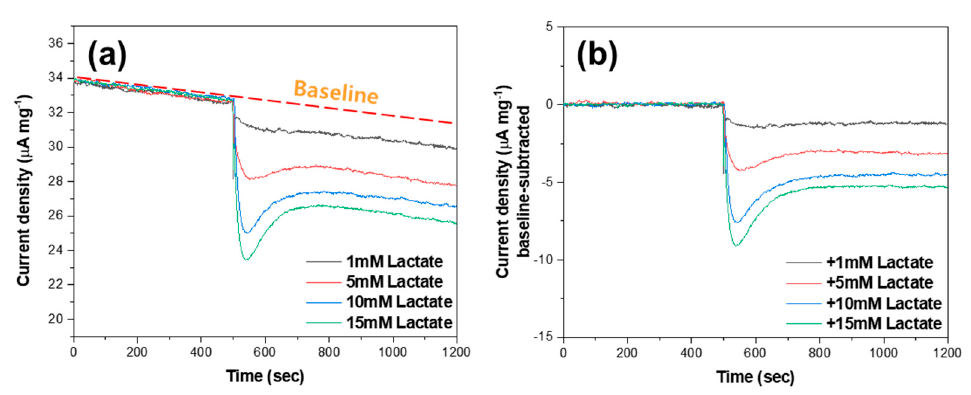
Figure 4. ( a ) Raw chronoamperogram and ( b ) baseline-subtracted chronoamperogram following the addition of lactic acid with the concentration of 1, 5, 10, and 15 mM at a detection potential of 0.68 V.